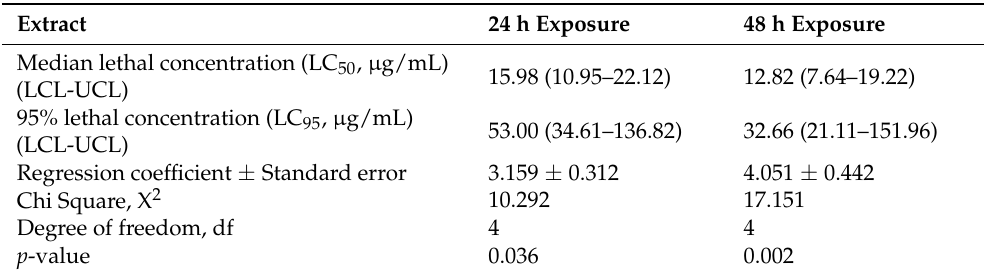
Table 1. Probit analysis of the larvicidal activity of the hexane extract of O. basilicum leaves against third instar Ae. albopictus larvae after 24 and 48 h exposure periods.